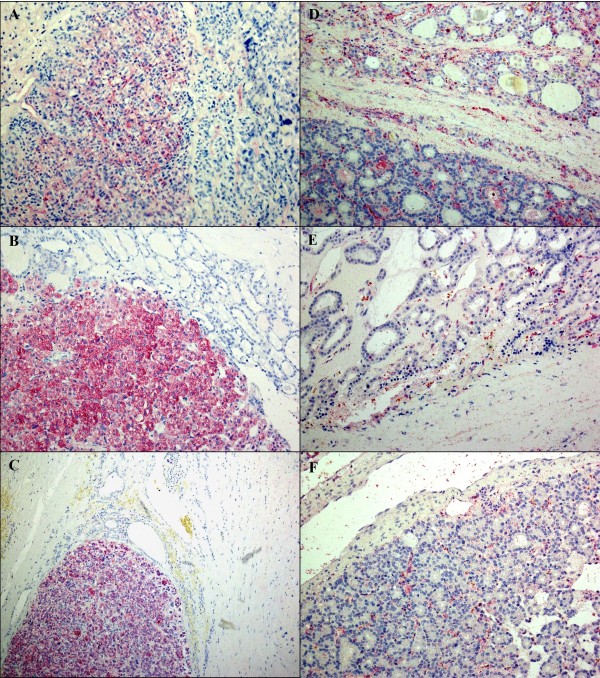
Representative picture of immunohistochemical staining of FTC (A-C) and FTA (D-F). Carcinoma tissue displays a cytoplasmatic staining of the tumour cells, while adenoma tissue remains unstained.